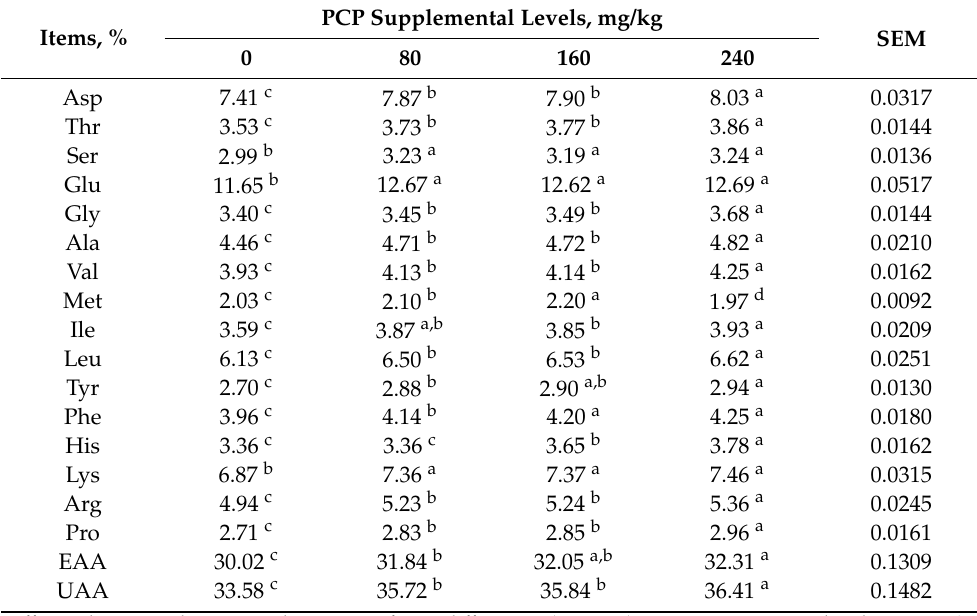
Table 5. Effect of anthocyanin-rich PCP on the amino acid of growing chickens. Items,